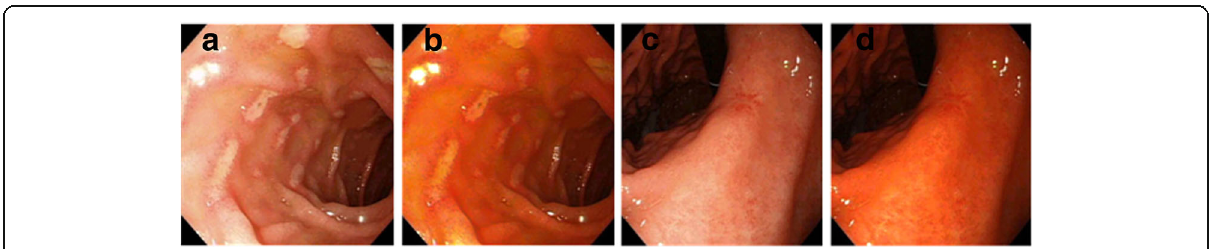
Fig. 4 Anti-degraded model. a , c Original images. b , d Haze-free images of ( a ) and ( c